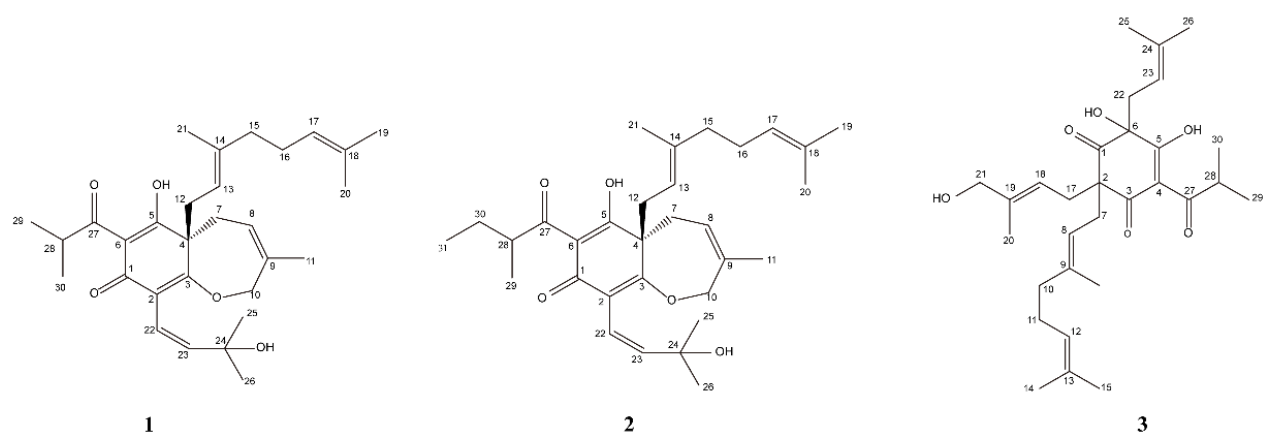
Figure 5. The chemical structure of new compounds 1 - 3 .